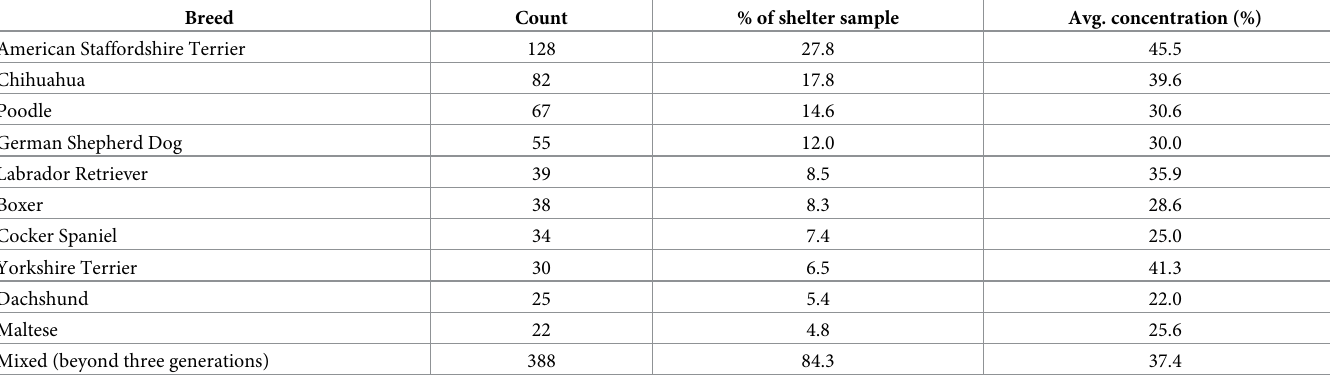
Table 4. Most commonly observed breed signatures at San Diego Humane Society.